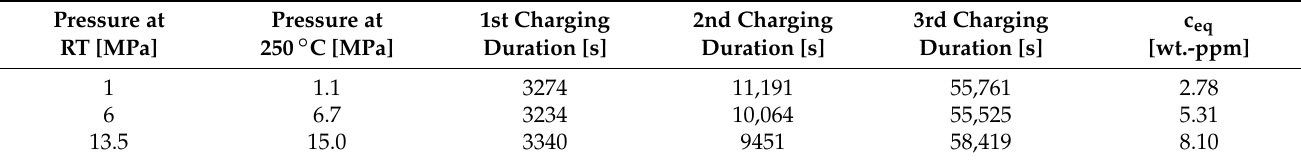
Table 3. Parameters used for the gaseous hydrogen charging of samples of the martensitic stainless steel 1.4418 at a charging temperature of 250 ◦ C and estimated hydrogen equilibrium concentrations c eq in weight ppm at the indicated pressures. Pressure